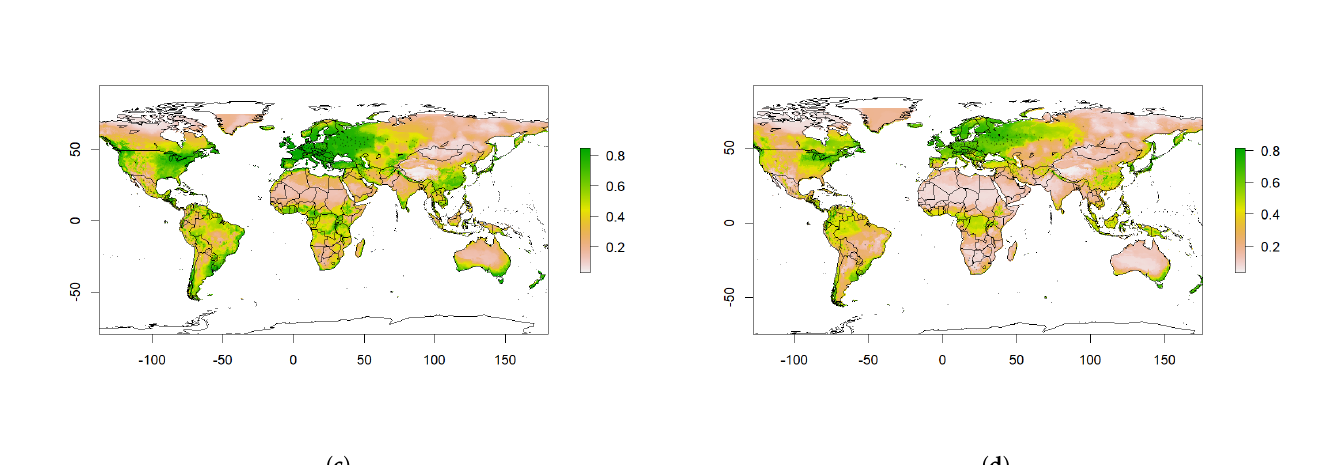
Figure 3. Future prediction of habitat suitability distribution for BRD using ME and BRT. ( a , b ) BTD and IBR, respectively, using ME. ( c , d ) BTD and IBR, respectively, using BRT. The greenish colour in the scale colour bar indicates suitable habitats for BRD occurrence, while the pinkish colour indicates habitats that are less suitable for BRD occurrence.